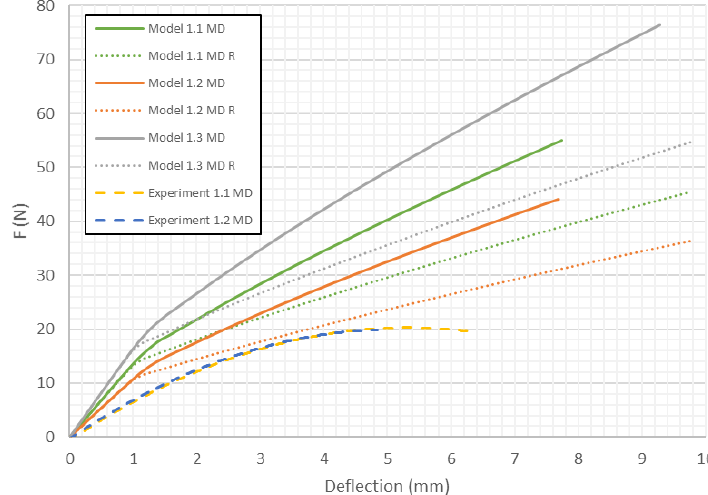
Figure 8. Deflection vs. force for Model 1 in MD.